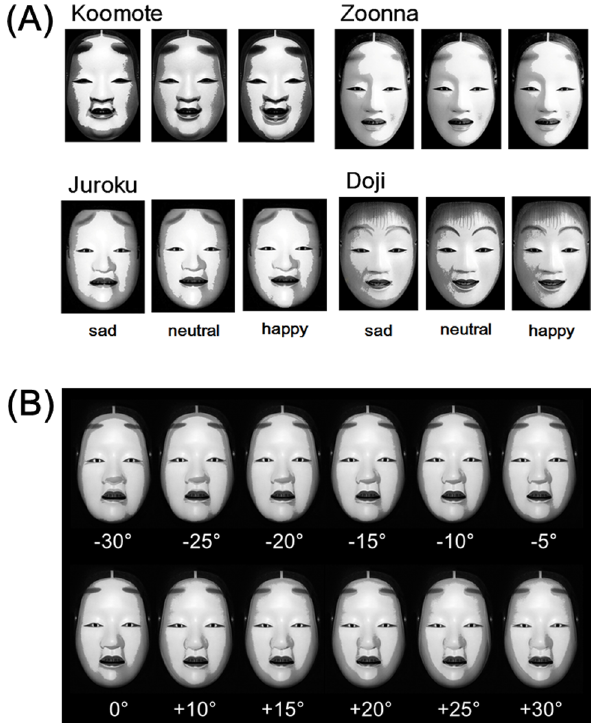
Figure 1. Noh mask images used as stimuli. ( A ) The 12 Noh mask images having overlaid shadows used in Experiment 1. Koomote, Zoonna, Juroku, and Doji each refers to the different type of the Noh mask. For each mask, there were three conditions regarding the emotional facial expressions: happy, neutral, and sad. ( B ) Test images used in Experiment 2, having shadows of the vertically tilted images overlaid to the frontal mask.